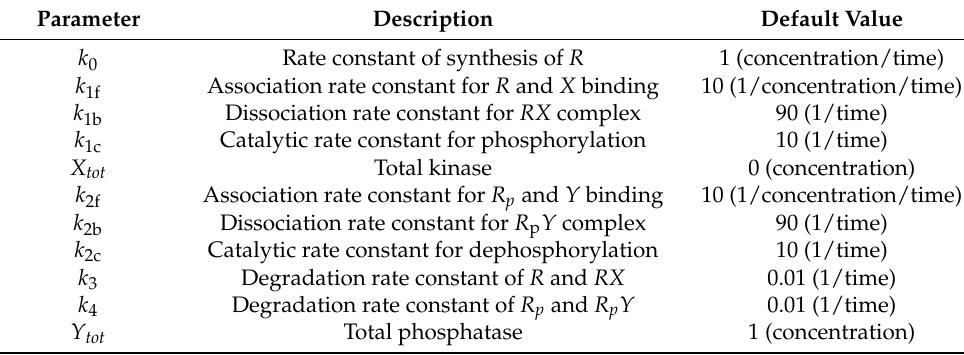
Table 2. Default parameter values for the full model in Figure